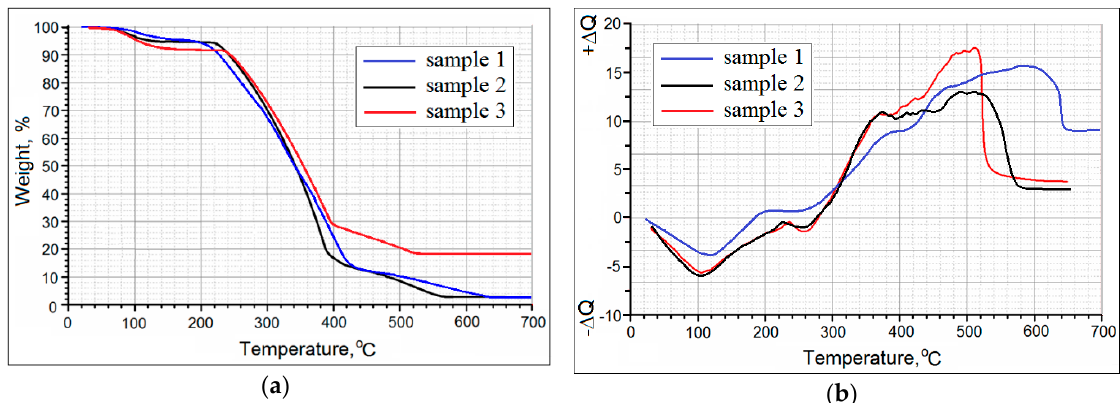
Figure 3. Thermogravimetric ( a ) and differential-thermal ( b ) analysis of (co)polymers: sample 1 – Ni(0)/ р HEMA/PVP mixture ( р HEMA:PVP = 80:20 m.p., [Ni] = 1,5 wt.%); sample 2 – Ni(0)/ р HEMA-gr-PVP composite (HEMA:PVP = 80:20 m.p., [Ni] = 1,5 wt.%); sample 3 – Ni(0)/ р HEMA-gr-PVP composite (HEMA:PVP = 8:20 m.p., [Ni] = 16 wt.%).